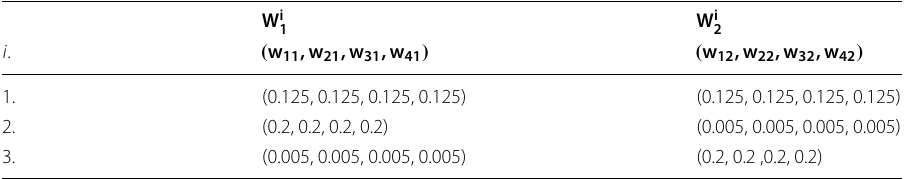
Table 9 Example 3. Chosen weights for TND-R model (16)